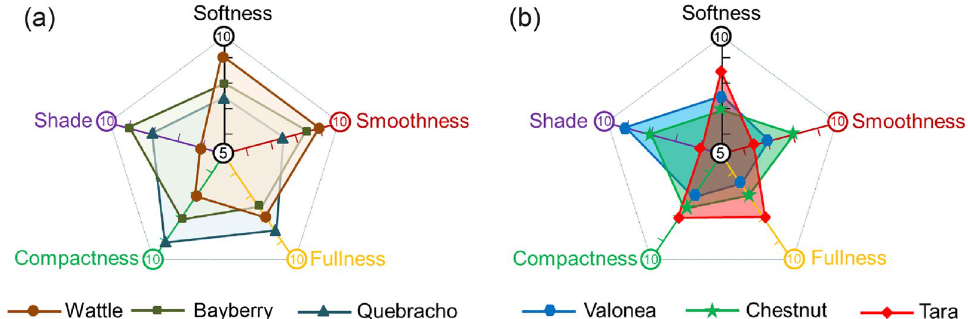
Fig. 5 The organoleptic properties of leather products from different combination tanning. a SACC leather. b SACC hydrolyzed tannins combination tanning +